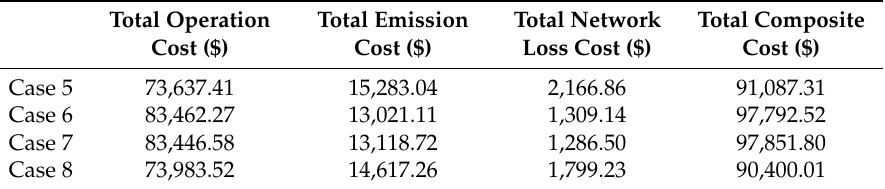
Table 6. Economic costs associated with Cases 5–8.